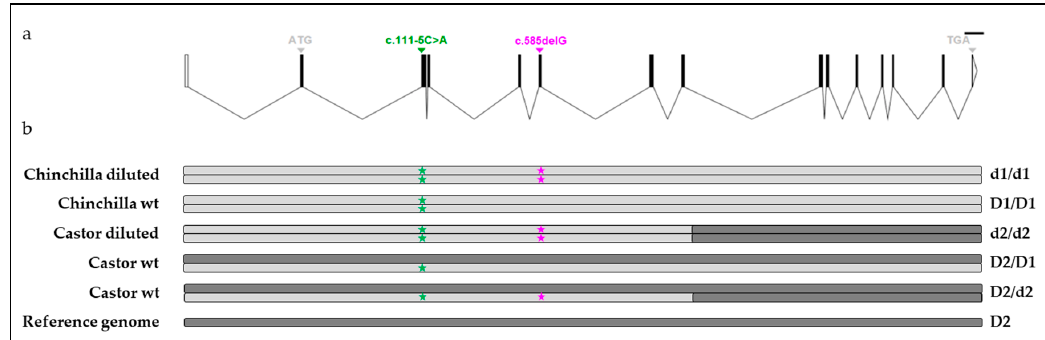
Figure 2. Characterization of haplotypes identified in Castor and Chinchilla breeds. ( a ) Graphical representation of the rabbit MLPH gene with the location of both the c.111 ‐ 5C>A and c.585delG variants. The coding sequence is in black, with START and STOP codons in exons 2 and 15, respectively. ( b ) Graphical representation of identified haplotypes. A total of 118 variants including 31 exonic variants were phased to reconstruct haplotypes from five individuals (Tables S1 and S3). Two diluted (d1 and d2) and two wt haplotypes (D1 and D2) were identified. Green and pink stars represent mutant alleles for the c.111 ‐ 5C>A and c.585delG variants, respectively.